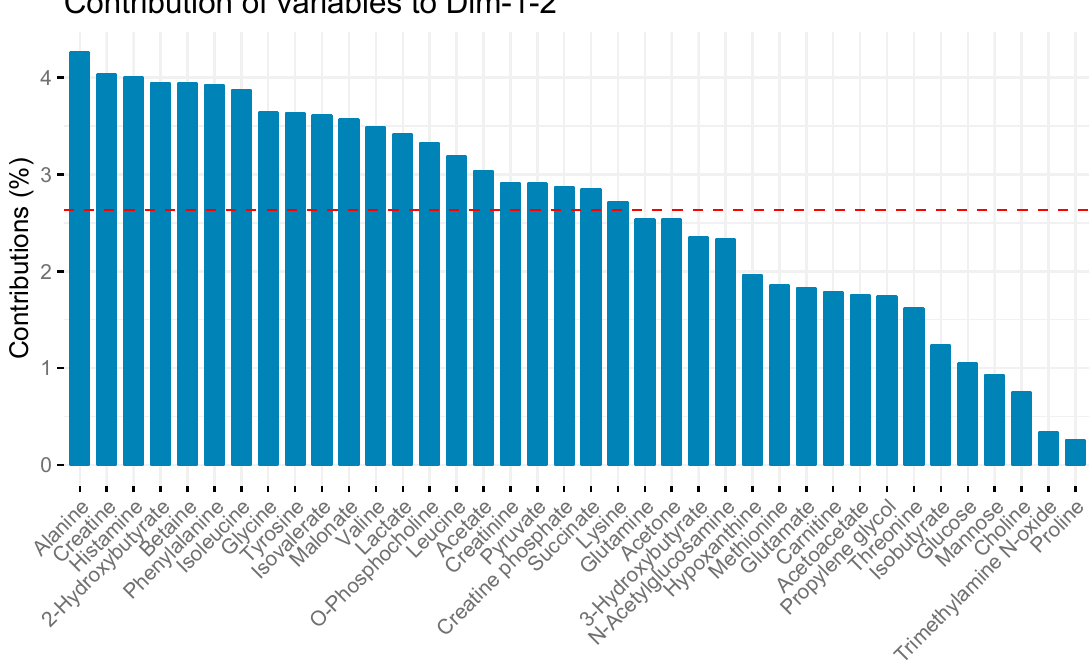
Figure 2. Metabolite contributions to serum sample variation in principal component analysis. The red line depicts the average amount of variability each metabolite contributes to overall variability captured in the PCA model. Metabolites with bars taller than the red line contributed more than the average, while metabolites with bars shorter than the red line contributed less. Metabolite contributions were calculated using the factoexta package, and are proportional to the sum of square of the loadings weighted by the eigenvalues.